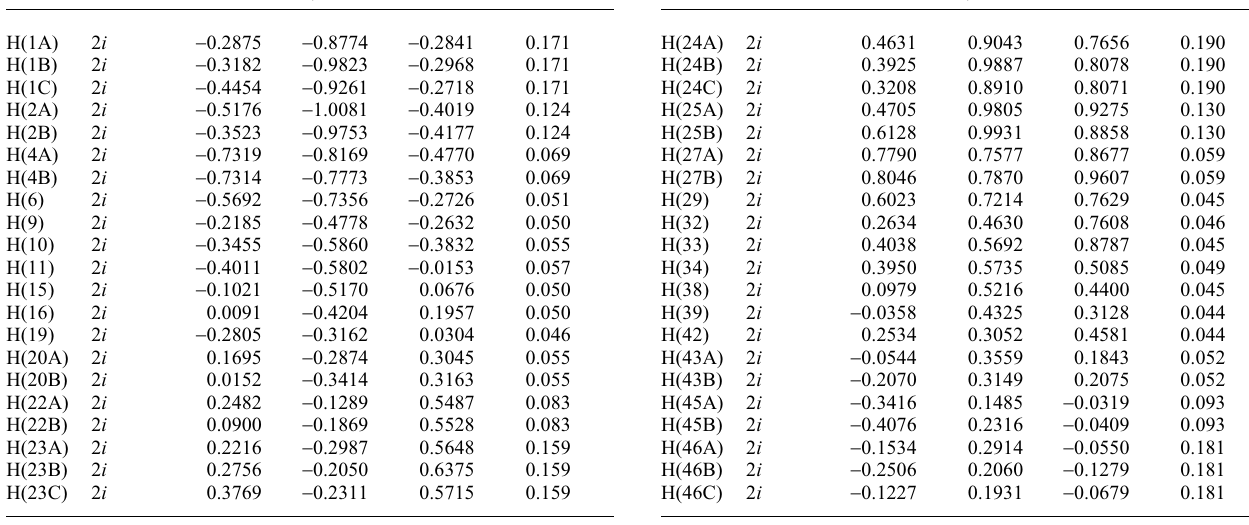
Table 3. Atomic coordinates and displacement parameters (in Å 2 ) .